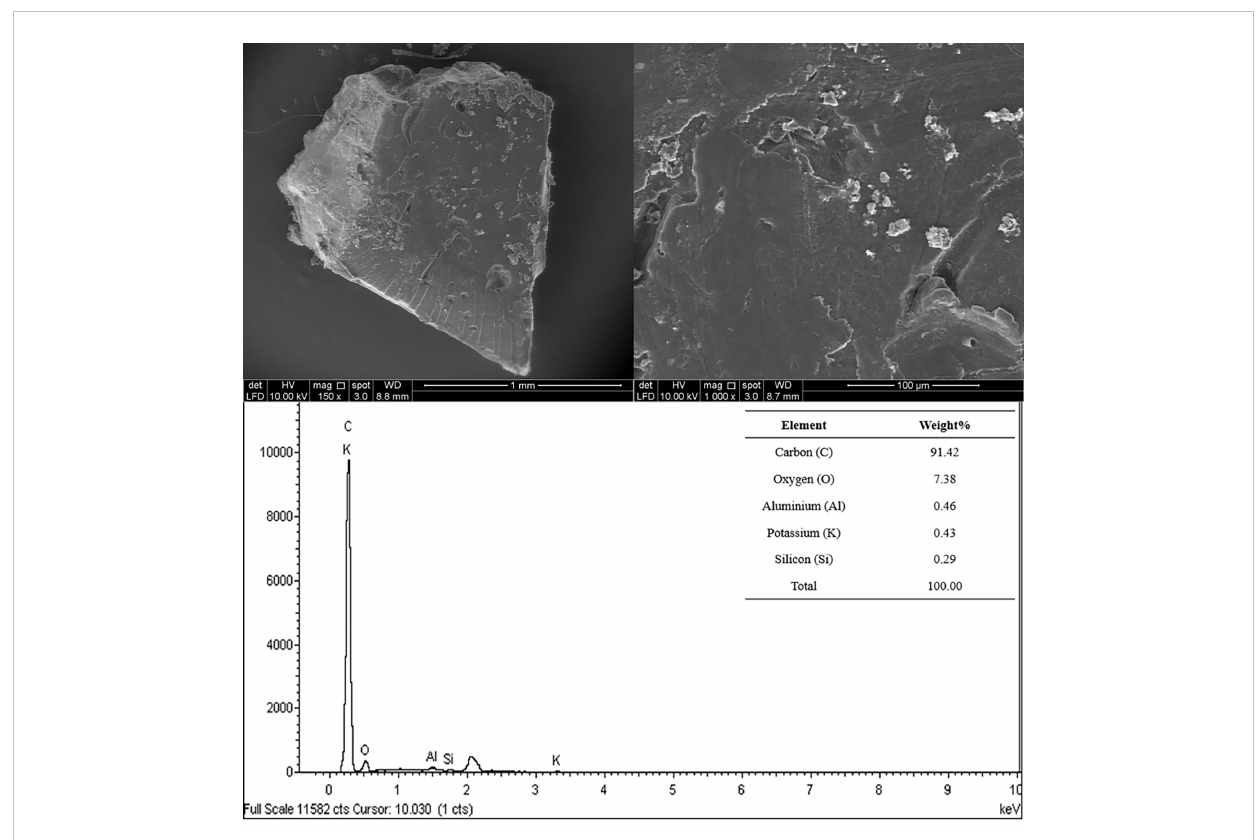
FIGURE 10 FESEM images of aged fragment and the corresponding EDX spectra of aged fragment recovered from the estuarine environment of